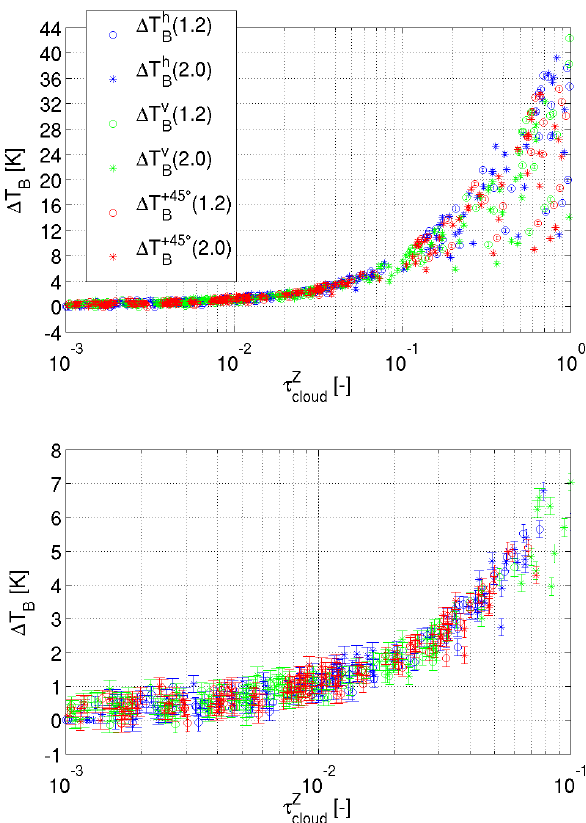
Fig. 9. Simulations of cloud induced signal, as function of polarisation specific cloud optical path, τ Z . The lower panel is a magnification of a part of the upper panel. The simulations are performed for a frequency of 347.5 GHz and a tangent altitude of 14 km .